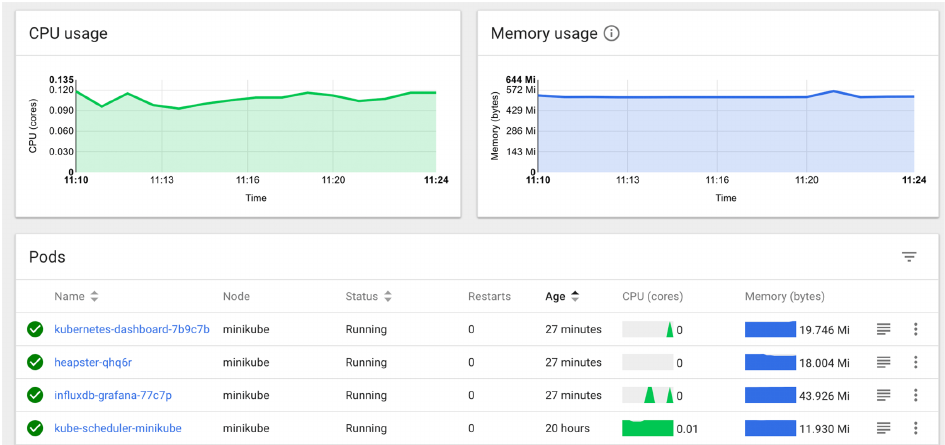
Figure 1. Kubernetes dashboard depicting CPU and Memory usage by Kubernetes pods [48].